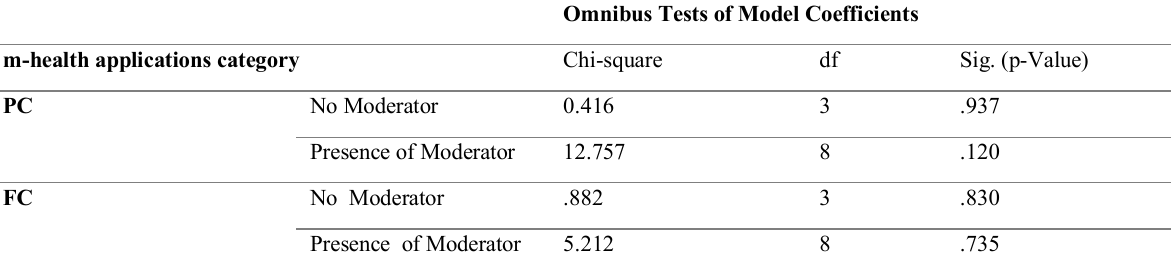
Table 5 below presents the Omnibus tests for Model Coefficients for each PC and FC m-health applications. Table 5: Omnibus tests of model coefficients transformational leadership style